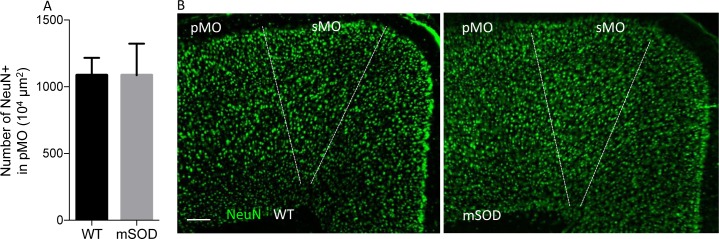
No neuronal loss in pMO of mSOD animal (P90).(A) Bar chart comparing NeuN+ neurons in primary motor cortex of adult mSOD animals (P90). No difference has been detected (WT: 1087 ± 128 vs mSOD 1087 ± 236), proving that changes in number of neurons projecting to primary motor cortex is not due to a loss of neurons in the injection area during disease progression. (B) Representative images of NeuN+ neurons in motor cortex (pMO and sMO) from WT and mSOD. Scale bar 200 µm.10.7554/eLife.36892.021Figure 6—figure supplement 1—source data 1.Detailed statistic concerning the number of NeuN +neurons in the motor cortex of adult mSOD animals (P90).